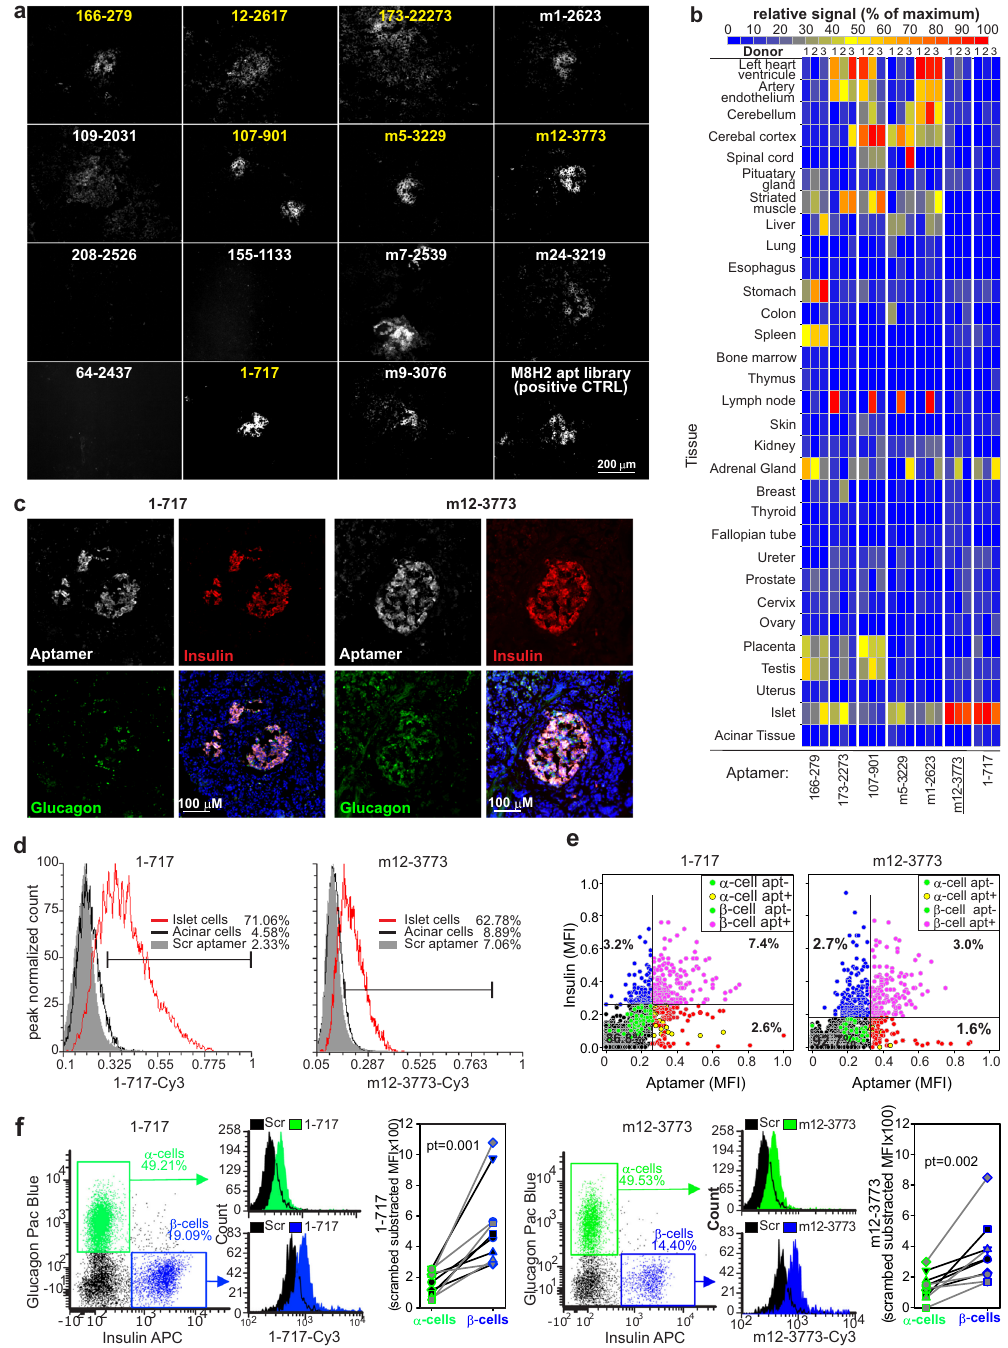
Fig. 2 Aptamer 1-717 and m12-3773 show high speci fi city for human islets. a Fifteen aptamers from the two SELEX strategies were produced, Cy3 labeled and used as immuno fl uorescence probes on human pancreatic tissues. One experiment representative of two is depicted. b The seven aptamers with the highest speci fi city for the islets (highlighted in yellow in panel a) were tested in FDA-approved tissue arrays against 30 different tissues from three different donors. Samples were counterstained with anti-insulin antibodies and images analyzed by Cell Pro fi ler. Integrated fl uorescence intensity resulting from all the cells or insulin-positive cells were fed into http://jcolorgrid.sourceforge.net/, and data are expressed as a percentage of highest intensity. Representative images from the different tissues are shown in Supplementary Fig. 2. c Sections of human pancreatic tissue stained with aptamer chimera 1-717 and m12- 3773 hybridized with cy5 guide RNA and with antibodies against insulin and glucagon were acquired by fl uorescence microscopy. One experiment representative of the other fi ve is shown. d Scanned images of all pancreatic sections stained against insulin and glucagon and with aptamer 1-717, aptamer m12-3773, or scrambled aptamers were analyzed with Cell Pro fi ler and FCS express. Median fl uorescence intensity (MFI) from islets and acinar tissue gates (Supplementary Fig. 4) is shown. e Images from 4 to 5 islets and surrounding tissues were acquired by confocal microscopy, processed by Cell Pro fi ler and MFI per single cells plotted. Spearman correlation: r = 0.639, p = 2 × 10 − 7 , and r = 0.225, p = 2 × 10 − 7 for aptamer 1-717 and m12-3773, respectively. f Single-cell suspension from islet preparation from cadaveric donors ( n = 9) were stained with cy3-labeled aptamer 1-717 or m12-3773, live dead dye, anti- insulin, and anti-glucagon antibodies, and analyzed by fl ow cytometry. Paired T test value is shown. Source data are provided as a Source Data fi le. NATURE COMMUNICATIONS| (2022) 13:1815